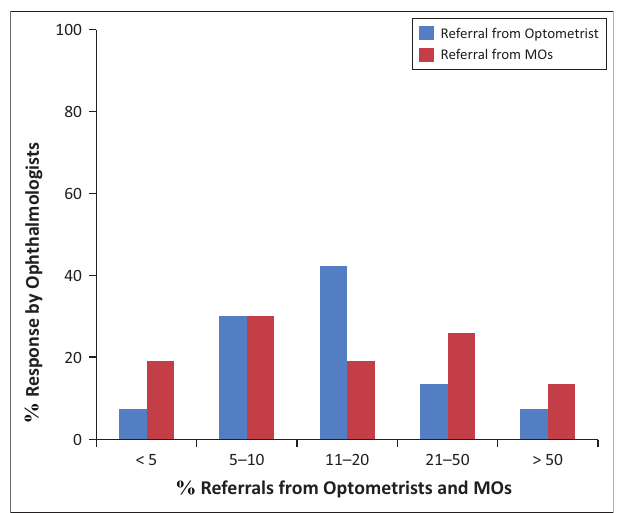
FIGURE 7: Referral percentages from optometrists and medical officers to ophthalmologists.